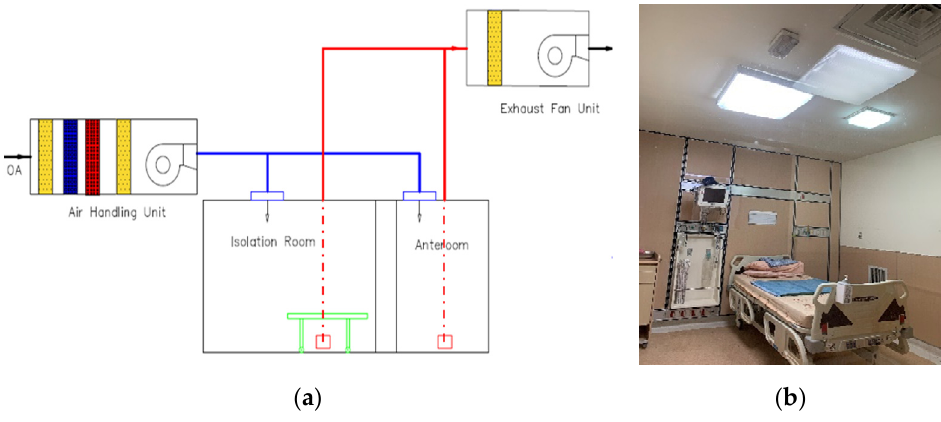
Figure 1. The investigated isolation room: ( a ) HVAC system; ( b )